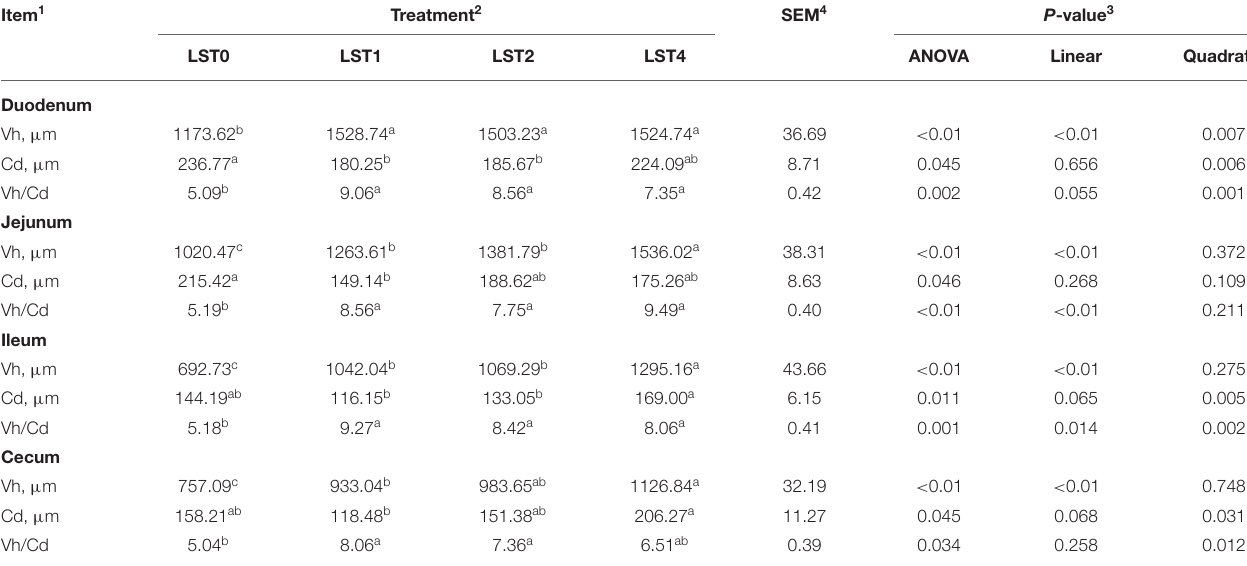
TABLE 6 | Effect of dietary LST powder supplementation on the morphology of the small intestine and cecum of broiler chickens ( n = 10). Item 1 Treatment 2 SEM 4 P -value 3 LST0 LST4 ANOVA Linear